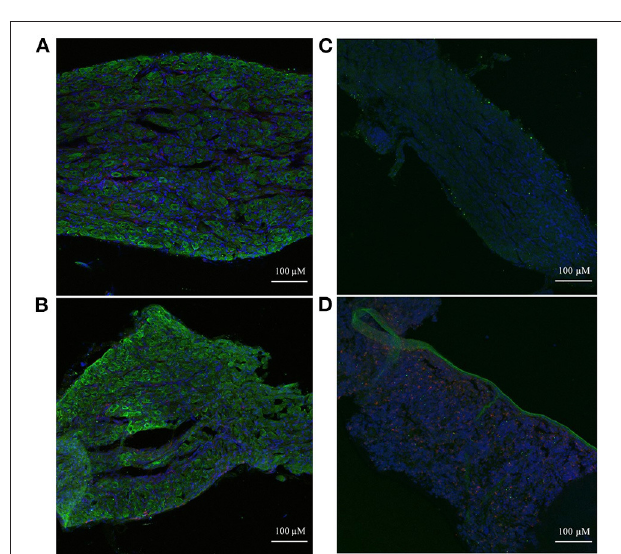
FIGURE 6 | Immunohistochemical images of sympathetic neurons (TH) and macrophages (CD68) in 3-week old Wistar and pre-SHR rat tissue. (A) Wistar stellate ganglion, (B) SHR stellate ganglion. These ganglia comprise a large number of sympathetic neurons (green) with some small macrophages (red) amongst them. The acellular spaces within the tissue likely reflect empty blood vessels following cardiac perfusion. (C) Wistar stellate ganglion stained with only DAPI and the secondary antibodies, serving as a negative control. There appears to be some 488 nm auto-fluorescence, but the tissue clearly lacks the cellular pattern of (A) . (D) Wistar spleen stained as a positive control for CD68 + macrophages; many punctate cells appear similarly to those of (A,B) . A large TH + ribbon which penetrates the rest of the tissue is interestingly also present, likely representing a sympathetic nerve